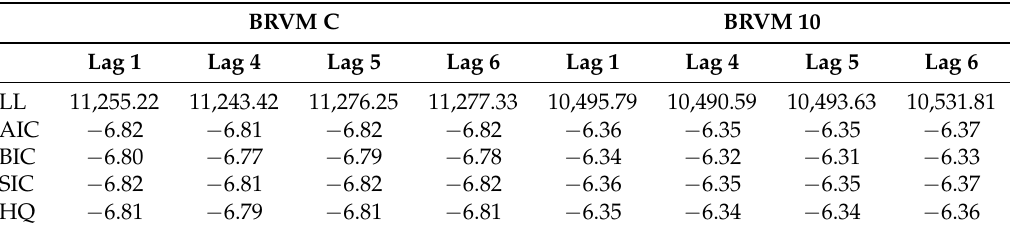
Table A1. Information criteria for model selection.